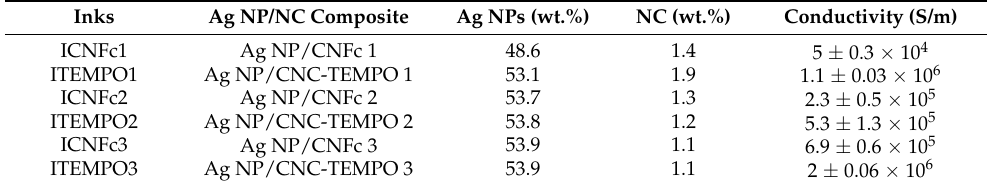
Table 3. Prepared inks’ solid composition and their electrical